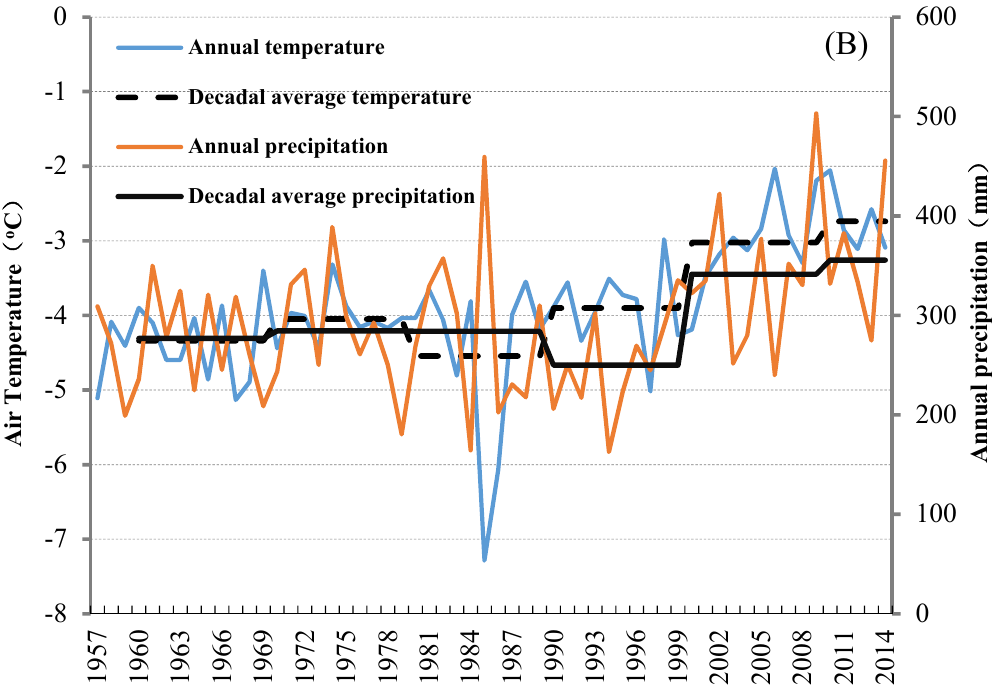
Figure 11. Relationship between glacier change and temperature and precipitation. ( A ) Glacier changes in area from 1973 to 2013 and glacier elevation surface changes from 1968 to 2013; ( B ) Air temperature and annual precipitation changes from 1957 to 2014.